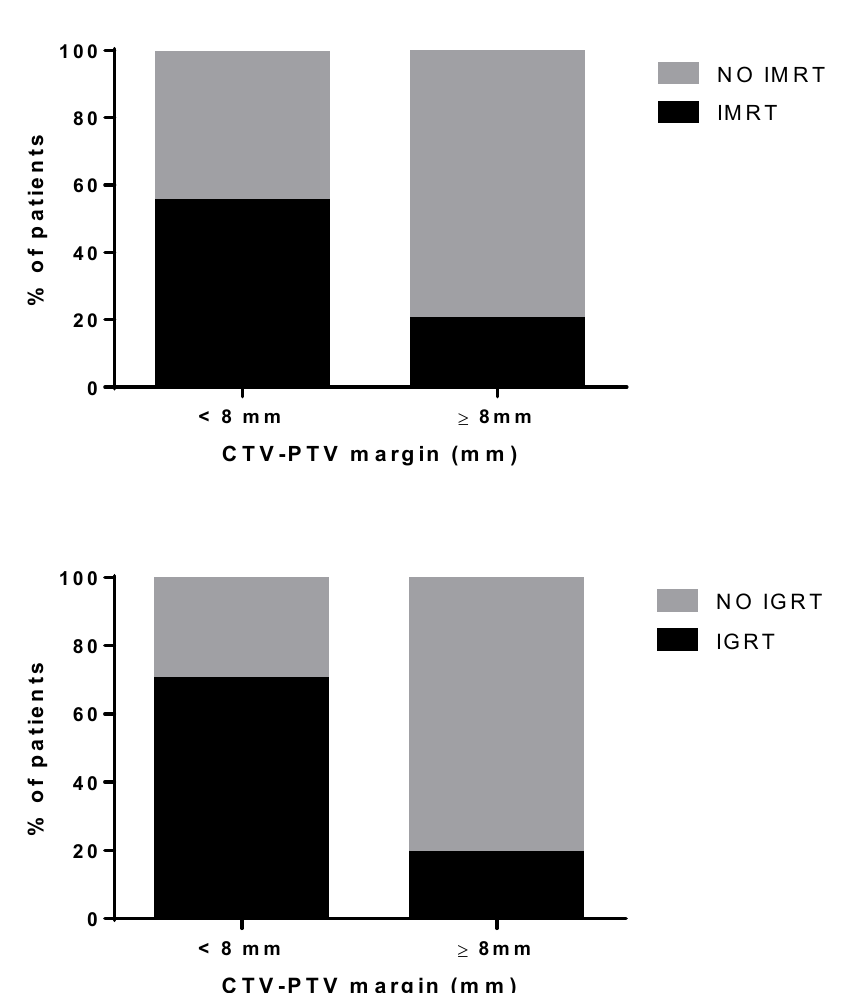
Figure 2. Percentage of treatment plans with CTV-PTV margin ≥ or <8 mm in IMRT vs. No IMRT treatments and IGRT vs. No IGRT treatments.